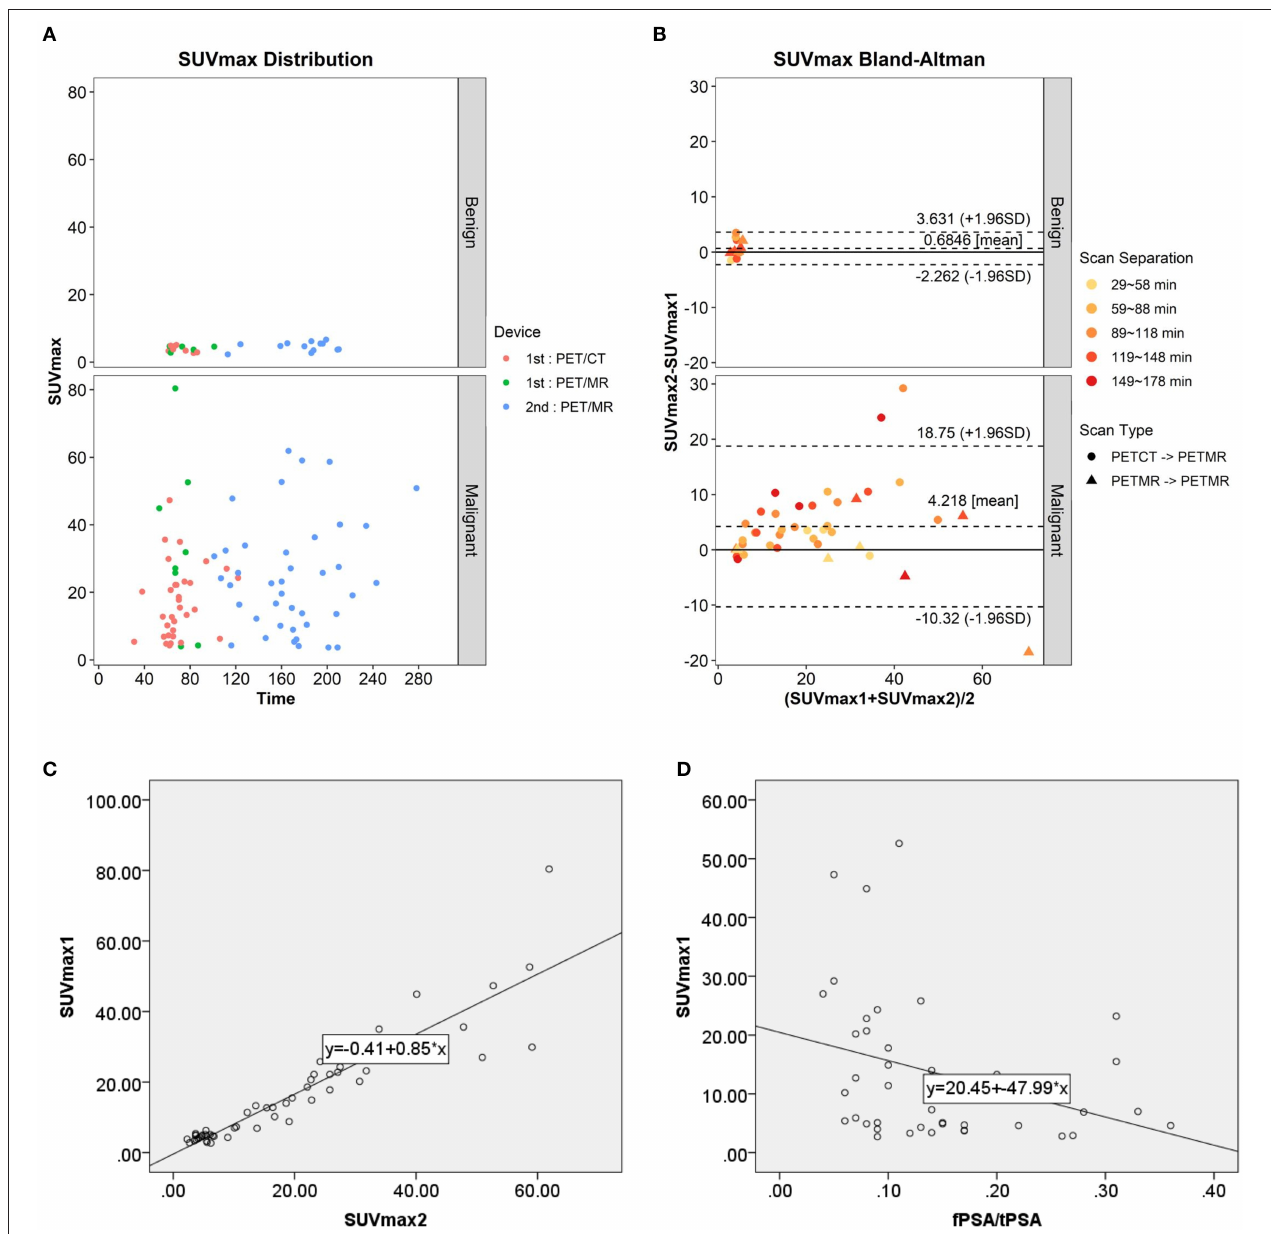
FIGURE 3 | (A) Scatter diagram of SUVmax from different scanner at different time point. (B) Bland–Altman plots of the differences against the means of SUVmax1 with SUVmax2. (C) Scatter plot and correlation of SUVmax1 and SUVmax2. (D) Scatter plot and correlation of SUVmax1 and